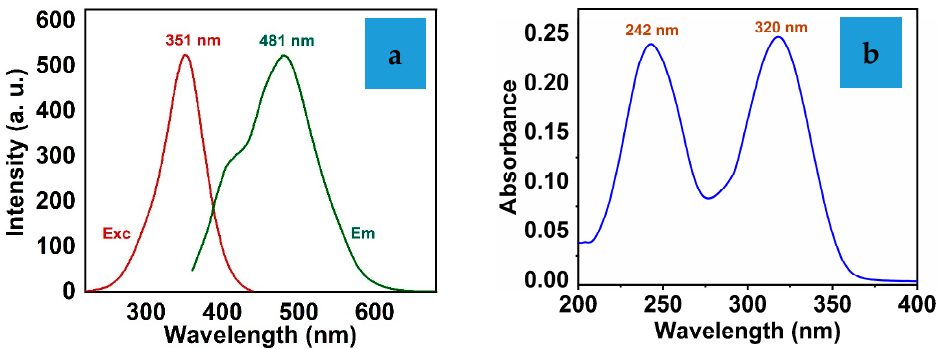
Figure 1. IXZD Optical Properties. ( a ) Fluorescence/excitation spectra under 351 nm excitation and ( b ) UV–Vis spectrum.